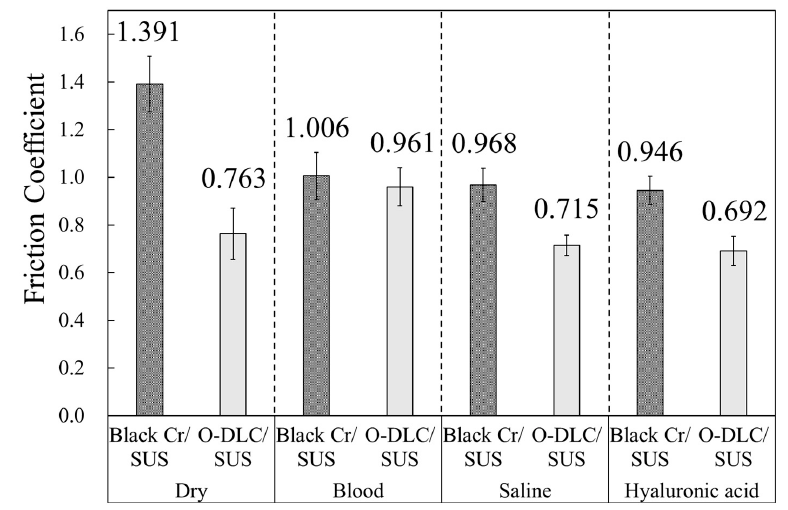
Figure 4. Coefficient of friction of each sample in a simulated body environment.